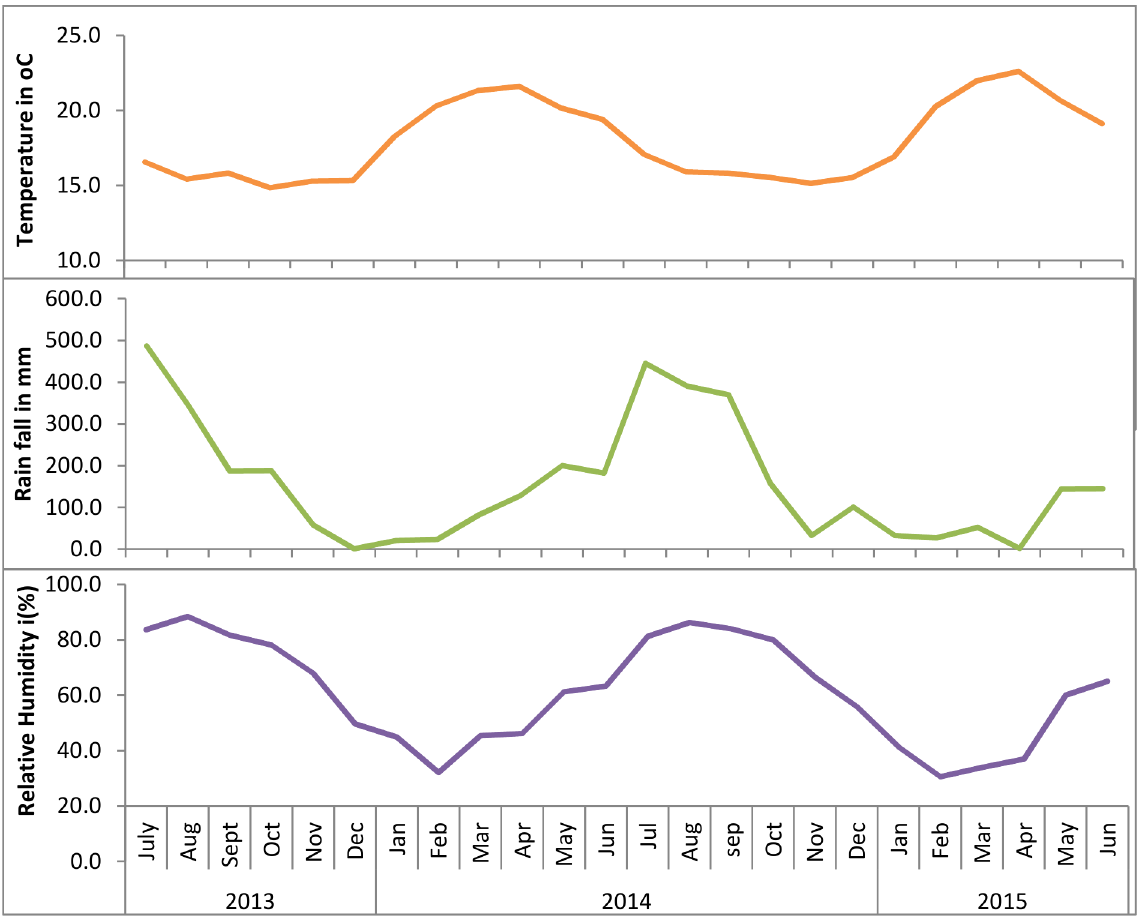
Fig 5. Trends of monthly averagetemperature, rainfall and relative humidity in northwest Ethiopia, from July 2013to June 2015.